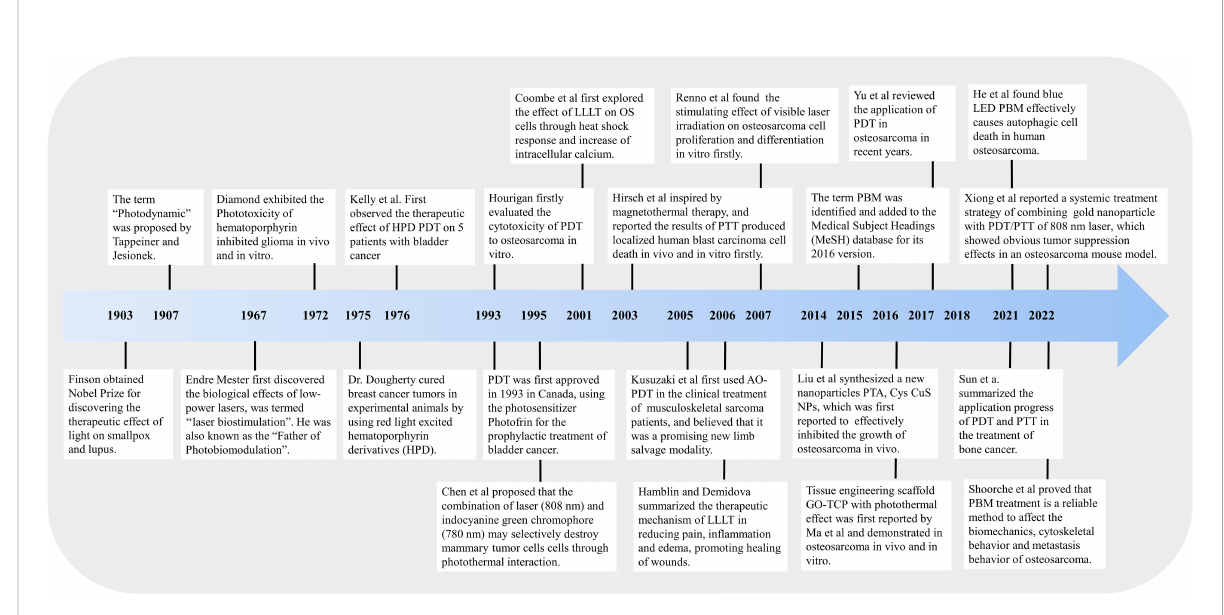
FIGURE 1 Schematic diagram of research progress of phototherapy (PDT, PTT, and PBMT) in the treatment of